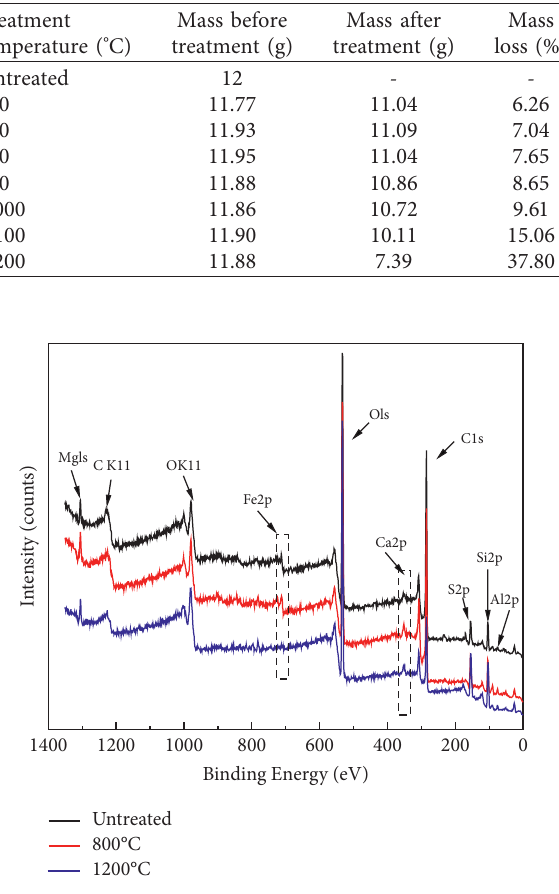
Figure 4: XPS analysis of the total spectrum of samples at different